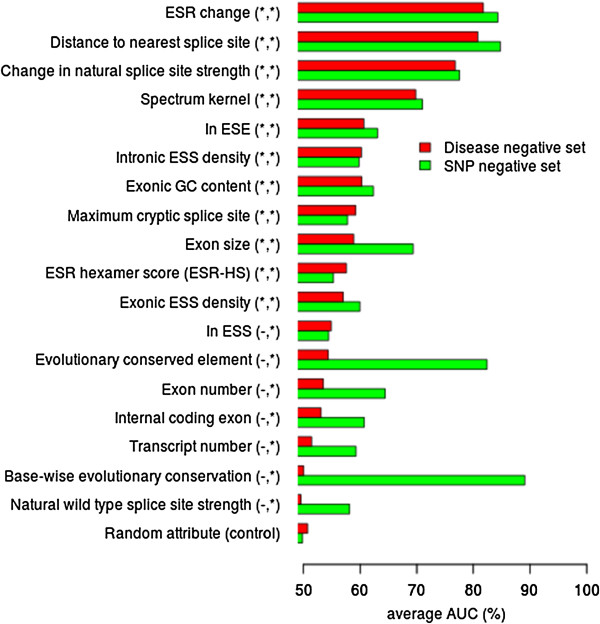
Feature ranking for Disease negative set versus SNP negative set (Iter. 1), shown by means of the average AUC using 10-fold cross-validation. The linear support vector machine (SVM) classifier was trained with only the specific feature (or feature subset) that was being tested. As a control, each training example had a randomly generated numerical value computed. AUC values for all features were then compared with the AUC produced by a classifier trained with only the randomly generated attribute by means of a Bonferroni corrected t-test (P < 0.05). Significantly different AUC values compared to the random attribute are indicated by asterisks in parentheses for the respective data sets (significant Disease negative set feature, significant SNP negative set feature). Features are ranked by reference to the Disease negative set.